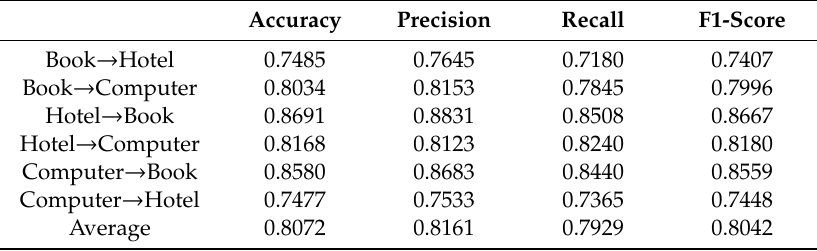
Table 6. Results of CNN_FT method at k = 500.